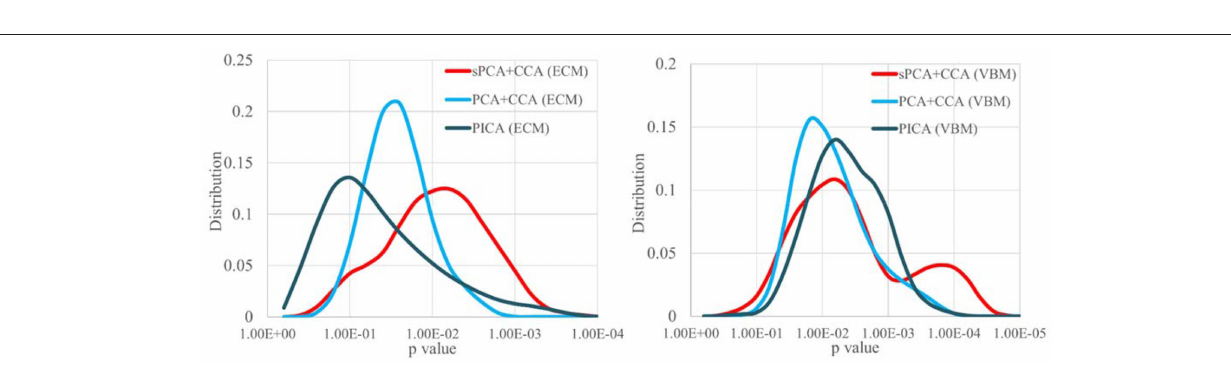
low-dimensional feature space. However, sPCA is different